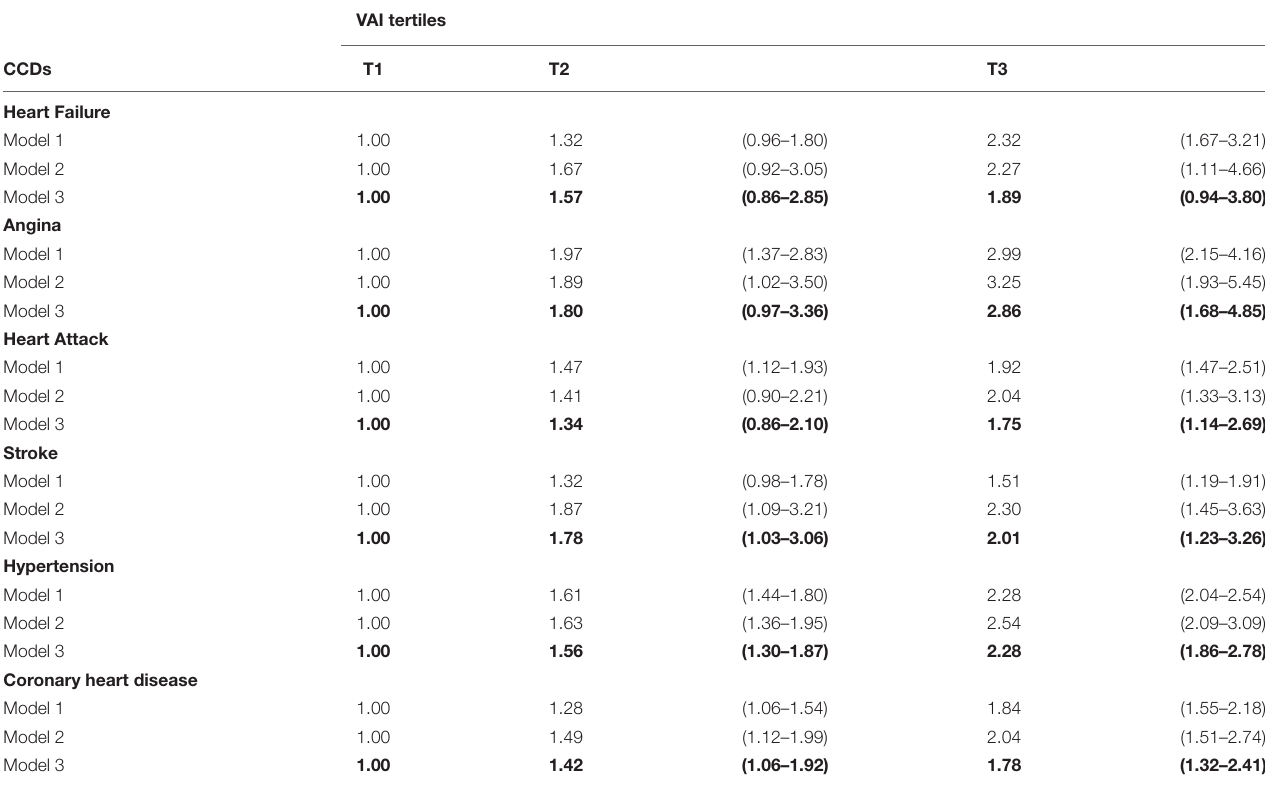
TABLE 3 | Weighted logistic model for the association of VAI tertiles with CCDs in NHANES (1999–2018). VAI